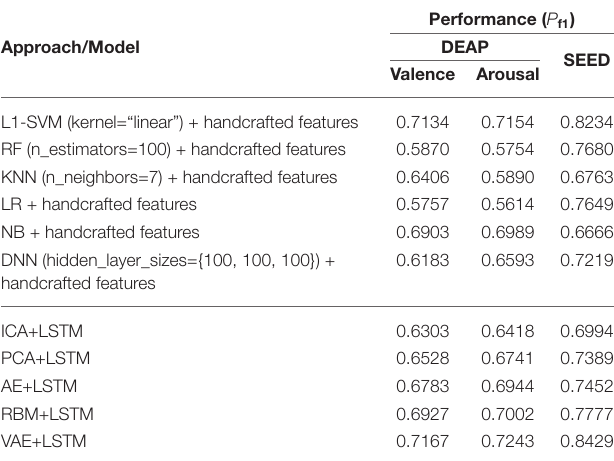
TABLE 5 | Performance comparison between this work and the baseline methods.